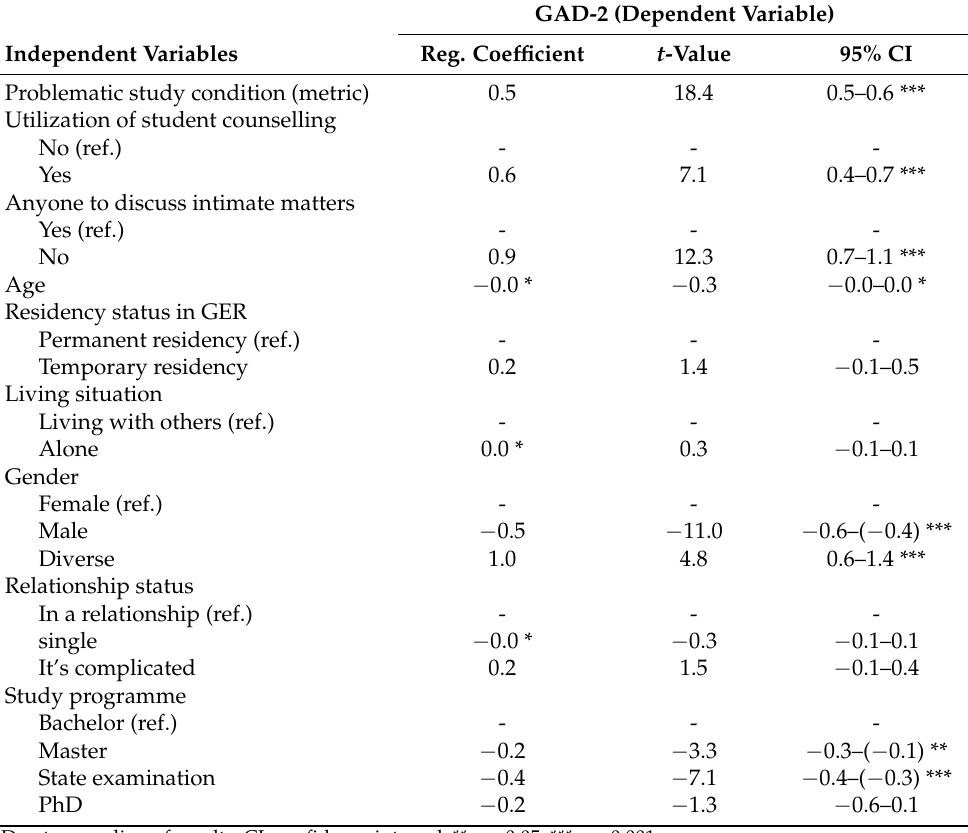
Table 8. Results of the linear regression model to determine the associations between anxiety symptoms and study conditions, as well as further